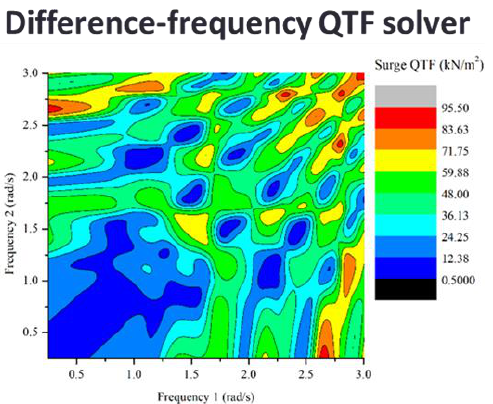
Figure 10. The amplitude of Difference-frequency QTF.